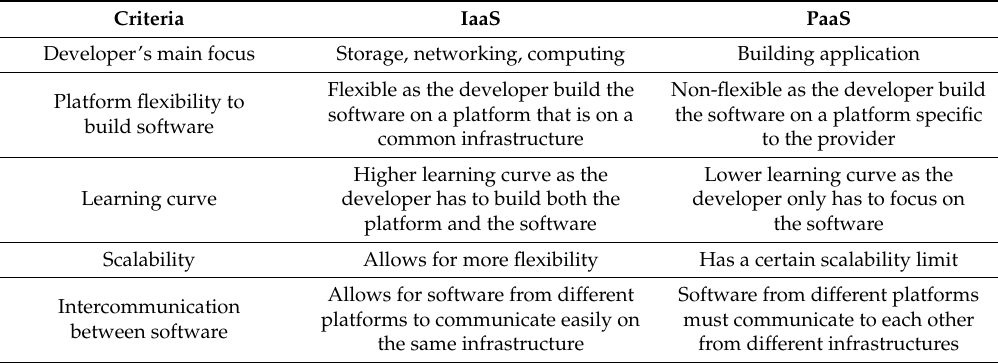
Table 1. The differences in criteria between the Infrastructure as a Service (IaaS) and the Platform as a Service